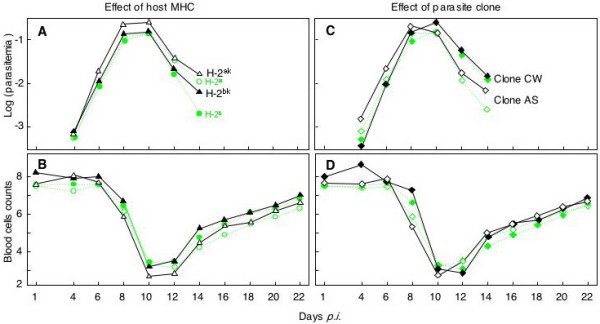
The effects of MHC and parasite clone on the course of disease symptoms. The mean parasitemia (log10-transformed) and the mean blood cell number (*109)/ml blood for MHC genotypes H-2ak (open triangles) and H-2bk (closed triangles), or pathogen clone AS (open diamonds) and clone CW (closed diamonds) are given over the course of the disease. Black symbols and lines refer to the data collected in this study on H-2ak and H-2bk mice, the green symbols and hatched lines refer to previously published results on homozygous H-2a and H-2b mice for comparison (Fig. 1 in [30]. See Table 1 for statistics.